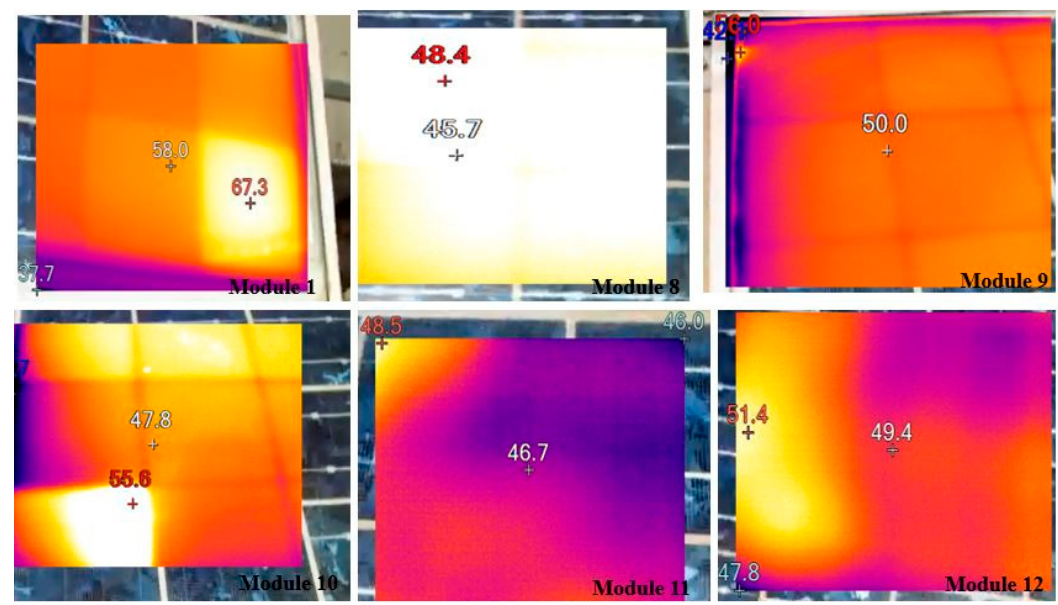
Figure 9. Thermal images of selected modules showing temperature hot spots.